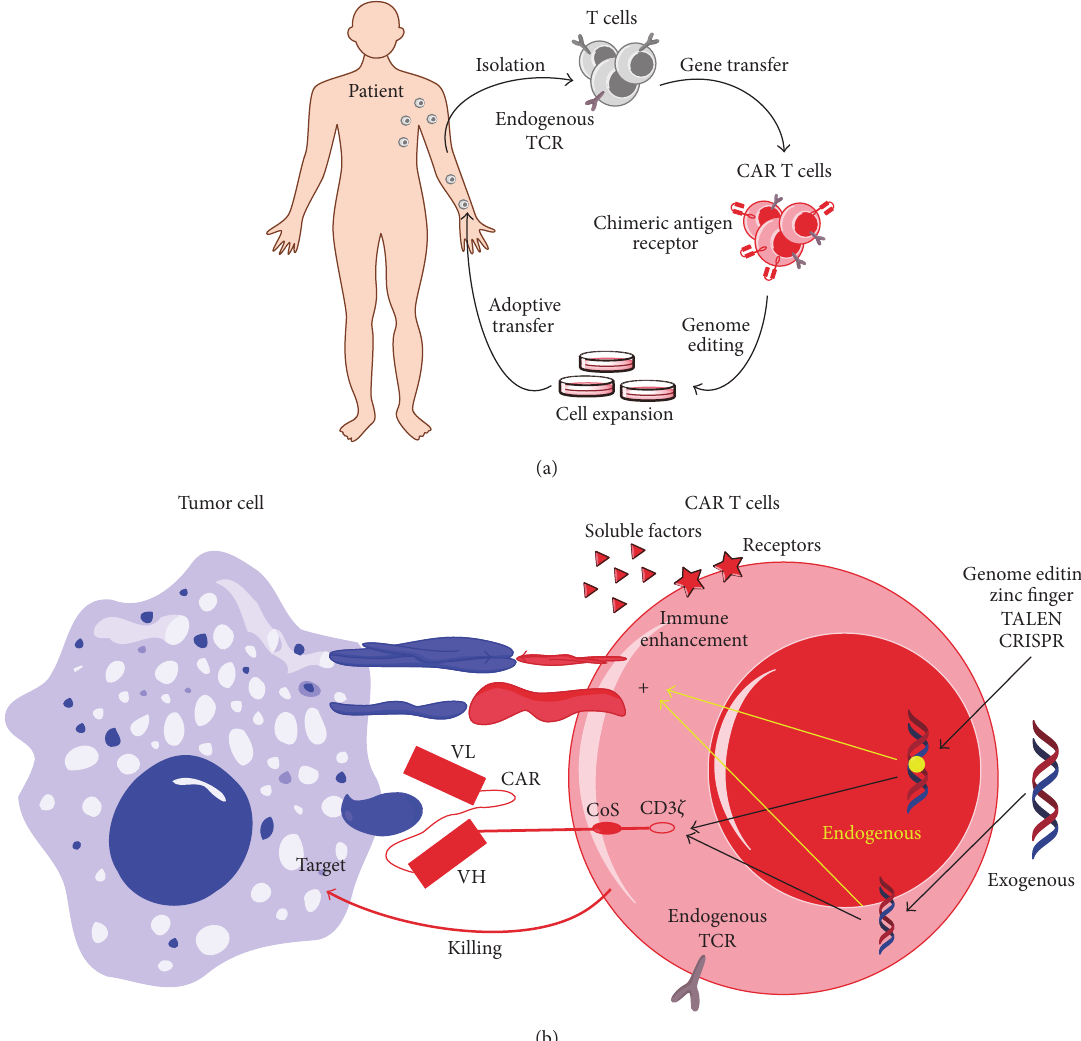
Figure 2: Chimeric antigen receptor (CAR) T-cell-based adoptive immunotherapeutics in hematological malignancies and its targeted recognition on tumor cells in an HLA-independent manner. (a) Flow chart of CAR-T-cell-based adoptive immunotherapeutics. Peripheral blood T-cells isolated from a patient with hematological malignancy are subjected to genetic modification with a relevant CAR that can target the surface antigens of malignant cells. Subsequently, the CAR-modified T-cells are subjected to ex vivo expansion and then administered via adoptive transfer to the patient. (b) Tumor cells are recognized and killed by CAR-T-cells in an HLA-independent manner; antitumor immunity can be enhanced and optimized through genome editing and gene transfer